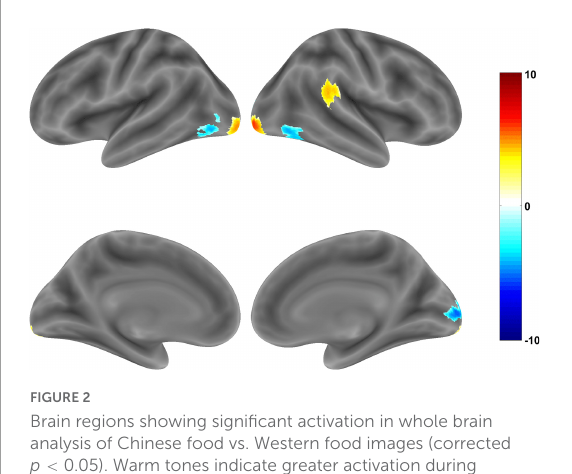
FIGURE2 Brain regions showing significant activation in whole brain analysis of Chinese food vs. Western food images (corrected p < 0.05). Warm tones indicate greater activation during exposure to Chinese food images and cool tones indicate greater activation during exposure to Western food images.